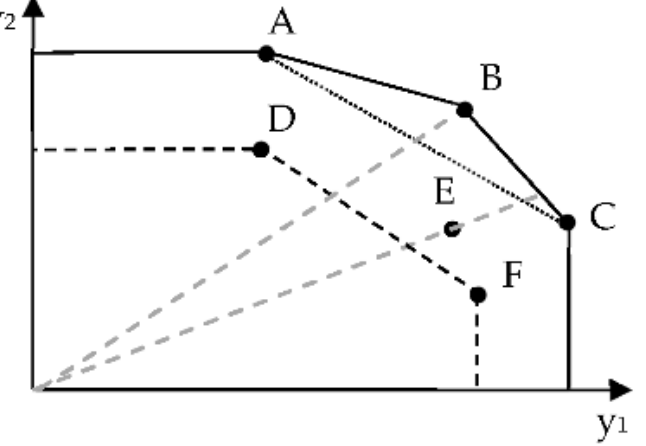
Figure 1. Frontiers in standard and super efficiency DEA models and the concept of technology competitors.